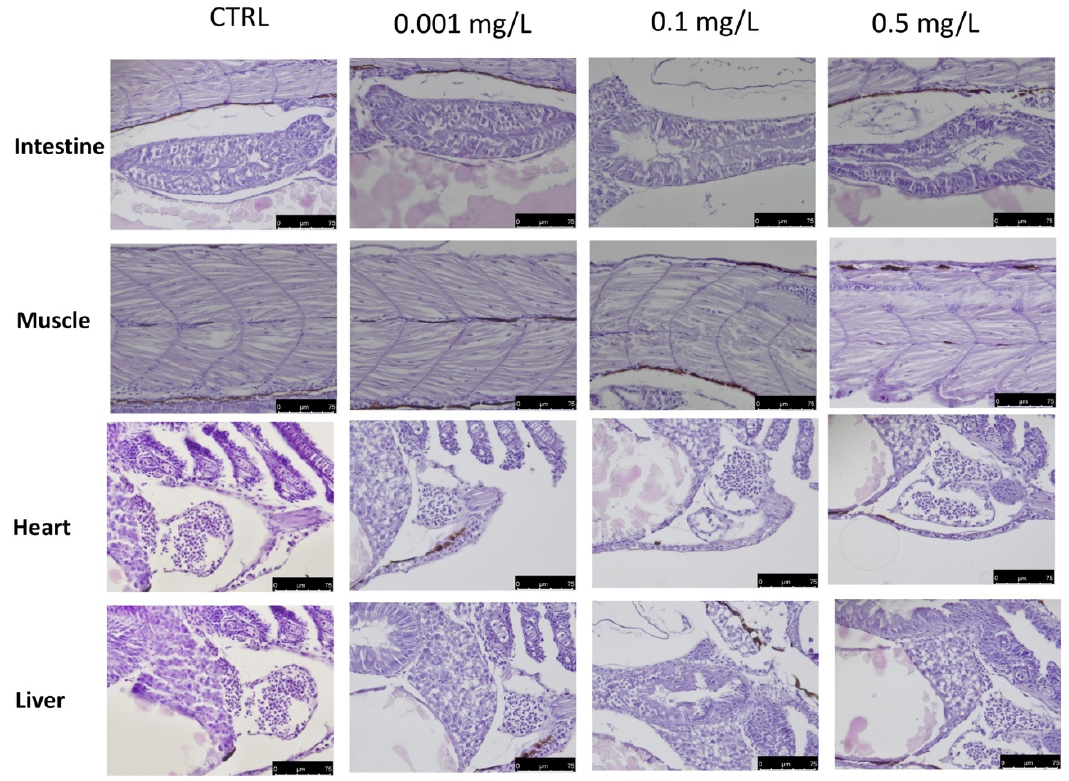
Figure 3. Histopathological changes in the hearts, livers, intestines and muscles of zebrafish larvae exposed to OXA at 96 hpf. Data are presented as means ± SEM, or median with interquartile range for non-parametric data of 10 larvae for each group. Scale bars 40× magnification.